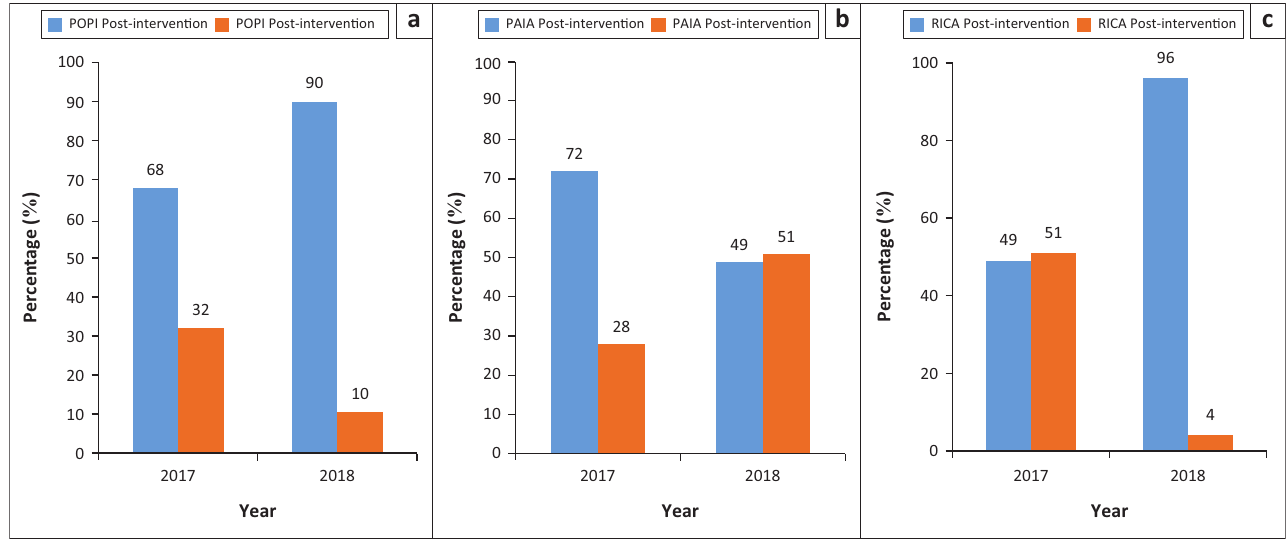
FIGURE 7: Post-intervention application knowledge of Protection of Personal Information, Promotion of Access to Information Act and Regulation of Interception of Communication Act for the years 2017 and 2018.